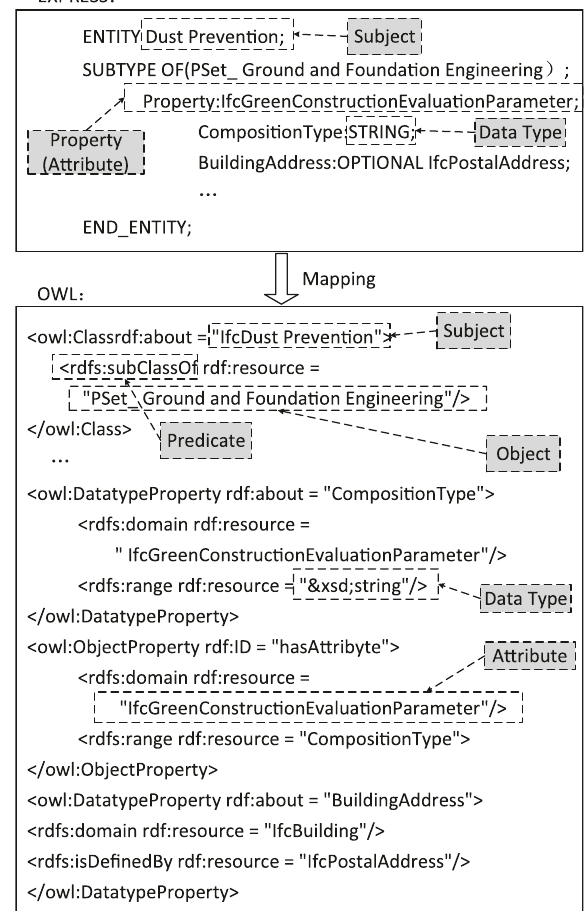
Figure 5: EXPRESS-OWL mapping of dust control